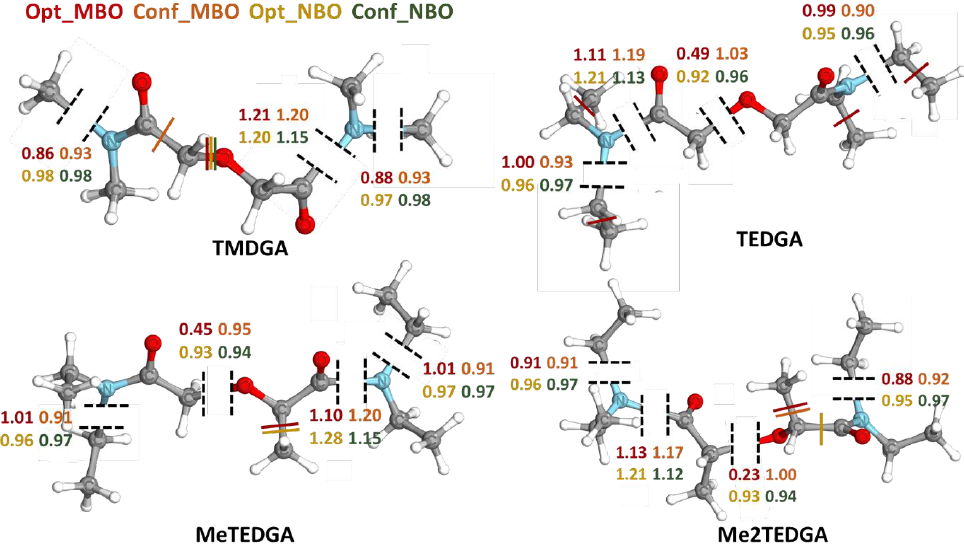
Figure 2. The breaking bonds from the experimental data (black lines) and the values of bond orders obtained by different calculation methods (color lines).